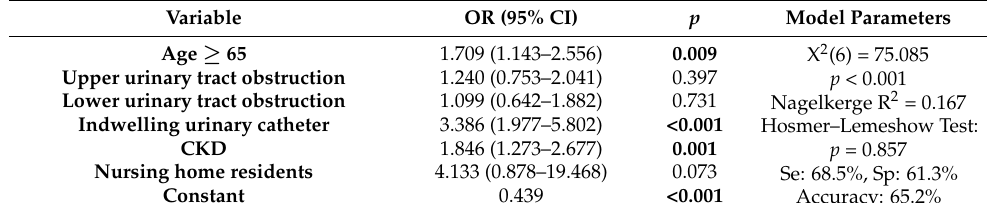
Table 4. Multivariate logistic regression for general antimicrobial resistance prediction.